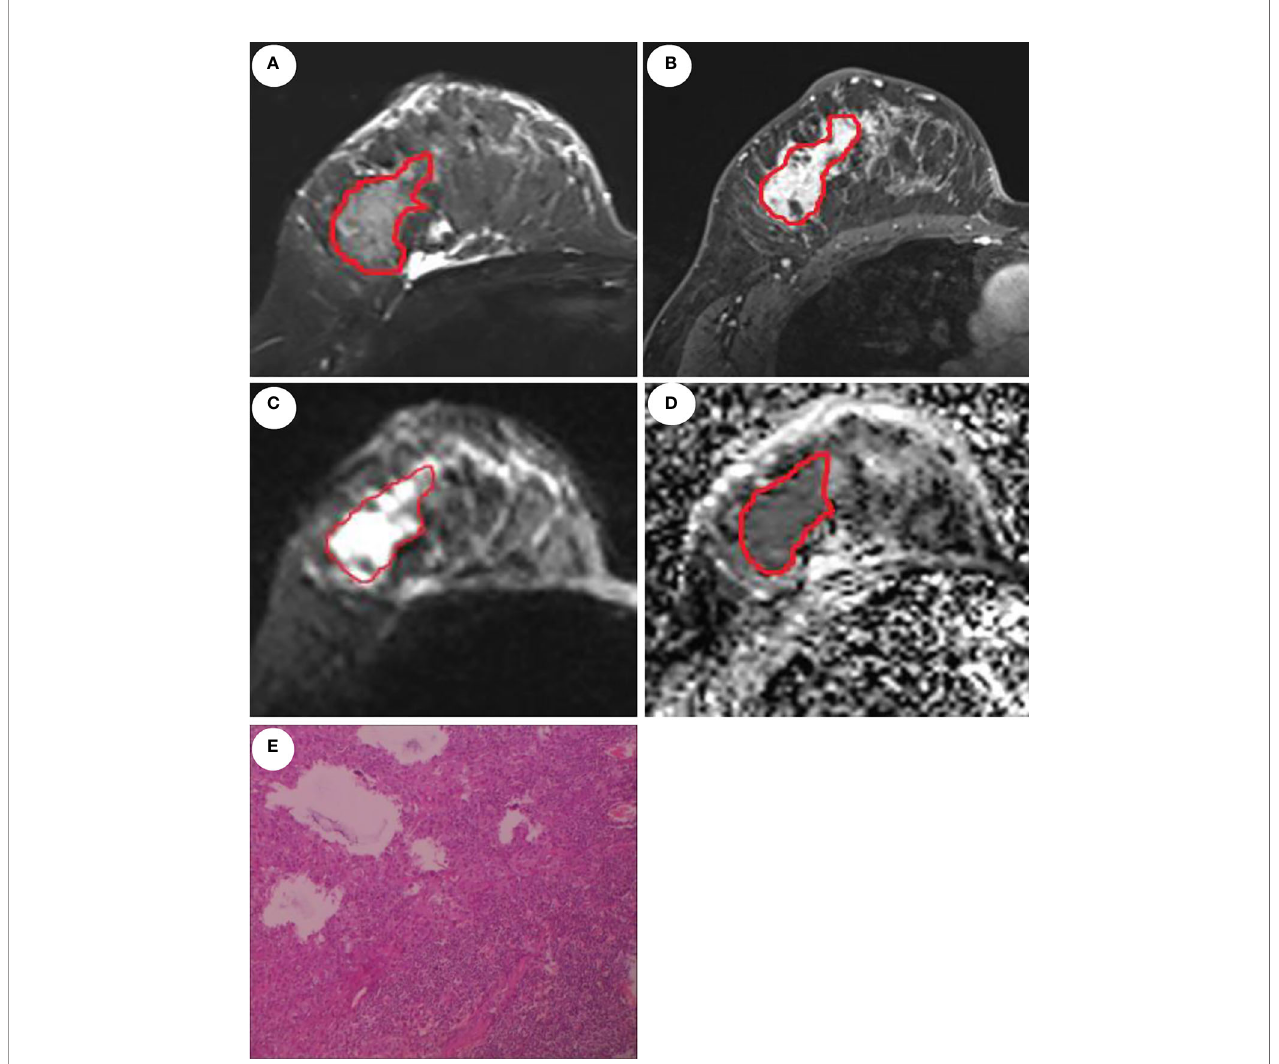
FIGURE 2 | MRI and pathological images of a 46-year-old patient with invasive ductal carcinoma and LVI. Manual delineation of the region of interest on the T2WI (A) , DCE (B) , DWI (C) , and ADC (D) , respectively. (E) displays the presence of